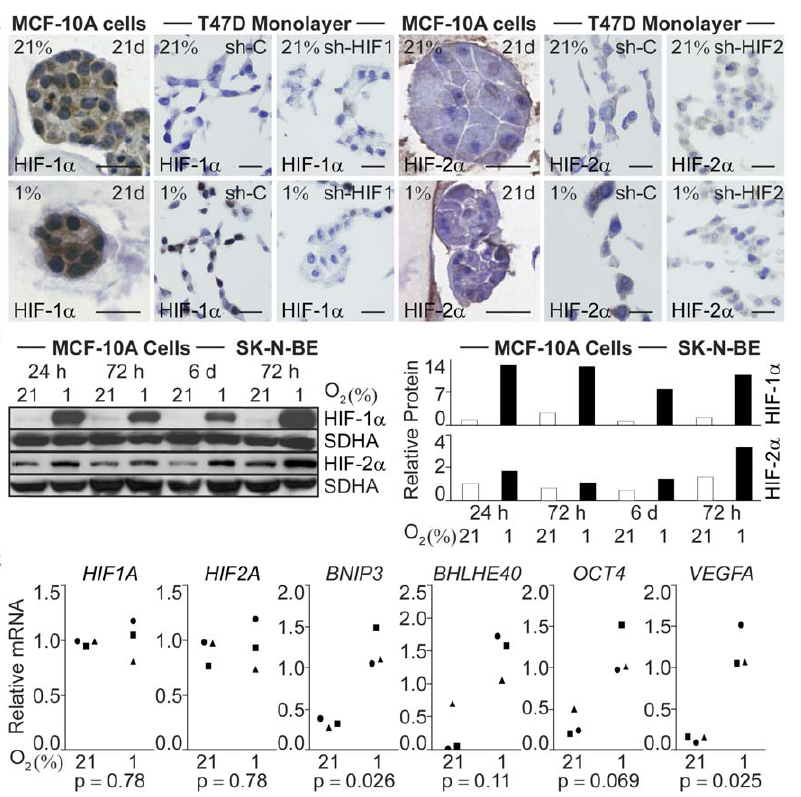
Figure 6. Expression of HIF-1 a , HIF-2 a , and HIF-target genes in normoxic and hypoxic breast epithelial cells. A. HIF-1 a and HIF-2 a immunohistochemical staining of MCF-10A acini-like structures after 21 days of 3D-culture at normoxia (21%) or hypoxia (1%). Sh-RNA-treated T47D breast cancer cells grown as monolayer and exposed to normoxia or hypoxia for 24h were used as controls. All cells were fixed in PFA and paraffin- embedded. Size bars 20 m m. B. Immunoblot analysis (left panel) of HIF-1 a and HIF-2 a in protein extracts of MCF-10A cells cultured in monolayer at 21% and 1% oxygen for the indicated period of time. Normoxic and hypoxic SK-N-BE cell extracts were used as controls. Quantification of the HIF signal intensity relative to the loading control (SDHA) (right panel). C. Relative mRNA expression of HIF1A , HIF2A , and the HIF-target genes BNIP3 , BHLHE40 , OCT4 , and VEGFA in normoxic and hypoxic MCF-10A cells retrieved from 3D-cultures 21 days post-seeding. Data are from three independent experiments and statistical analysis was performed with Student’s paired t-test (p).